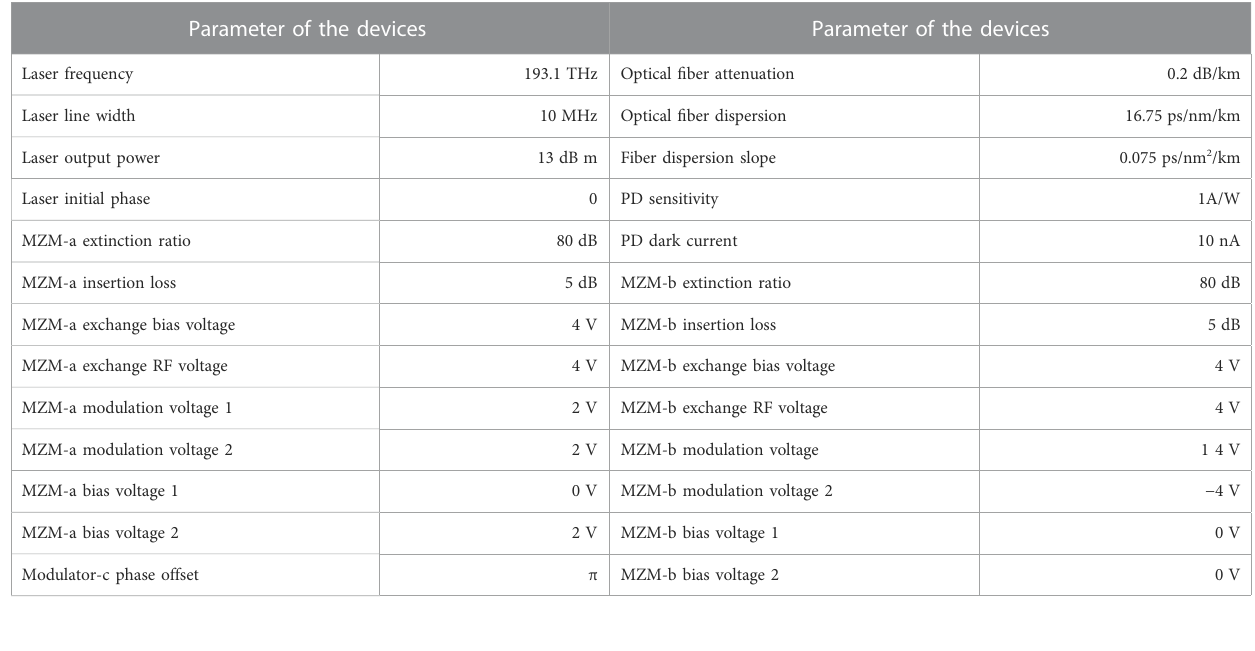
TABLE 1 Parameters of the devices in the simulation.